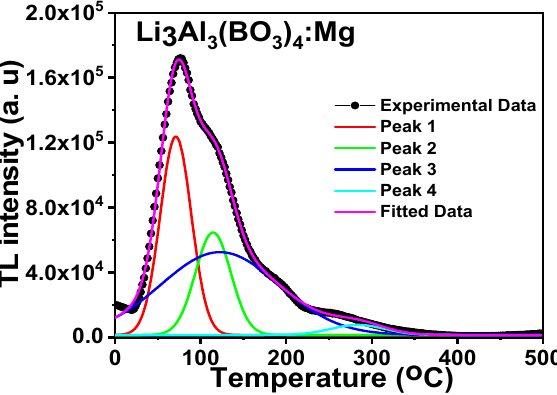
Figure 11. The glow curve deconvolution plot of Mg ‐ doped lithium aluminium borate.